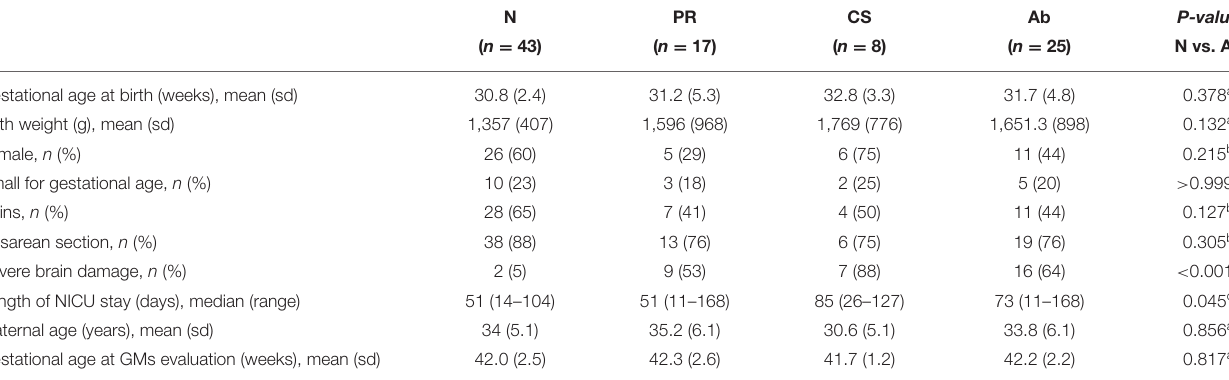
TABLE 1 | Baseline characteristics of the population presented for normal (N), poor repertoire (PR), cramped synchronized (CS), and abnormal (Ab) comprising both PR and